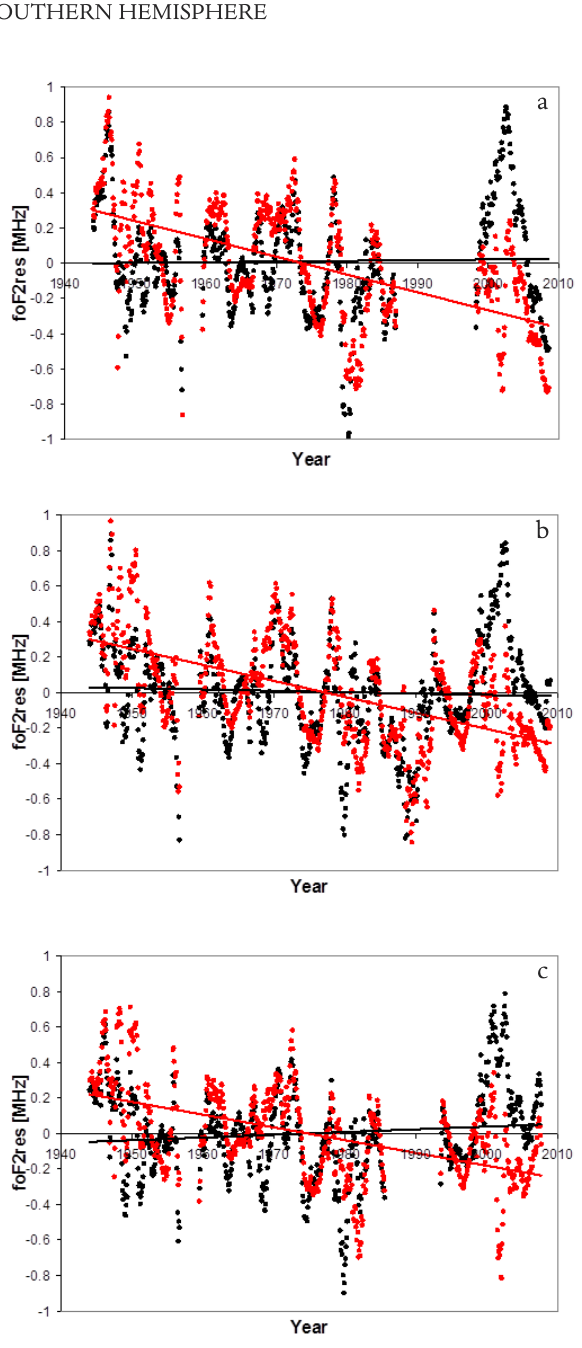
Figure 2. foF2 residual for (a) Brisbaen (27.5°S, 152.9°E), (b) Can- berra (35.3°S, 149.0°E) and (c) Christchurch (43.6°S, 172.8°E), after filtering seasonal and solar activity effects using Rz (black dots) and F10.7 (red dots) as solar EUV proxy and fitted linear trend (corre- sponding solid